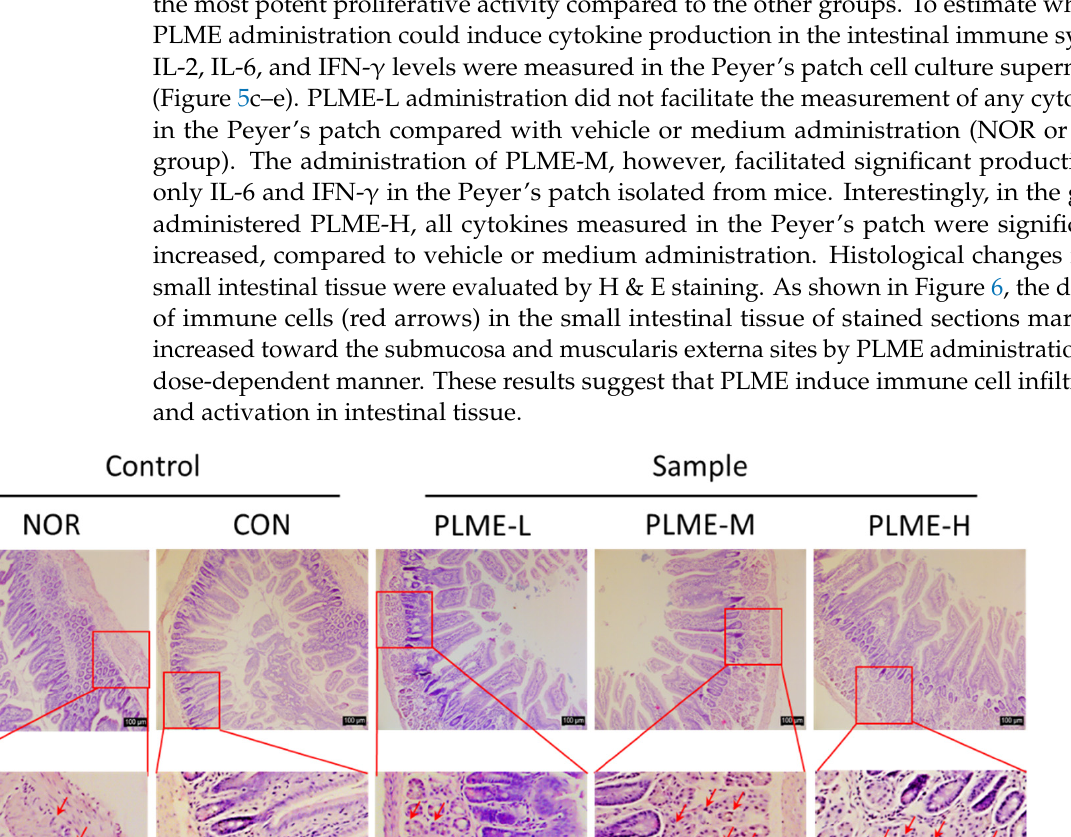
Table 2. Chemical components, sugar, and glucan composition of PLME.